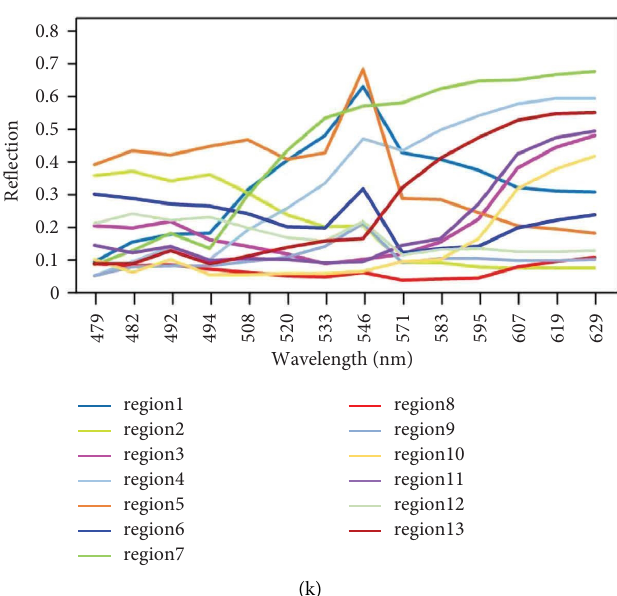
Figure 9: X-rite color card hyperspectral imaging results and analysis. (a)–(h) X-rite images from 8 selected spectral channels. (i) Color image recovered from 16 spectral channels. (j) SAM classifcation image. (k) Representative spectra from the 13 regions labeled in